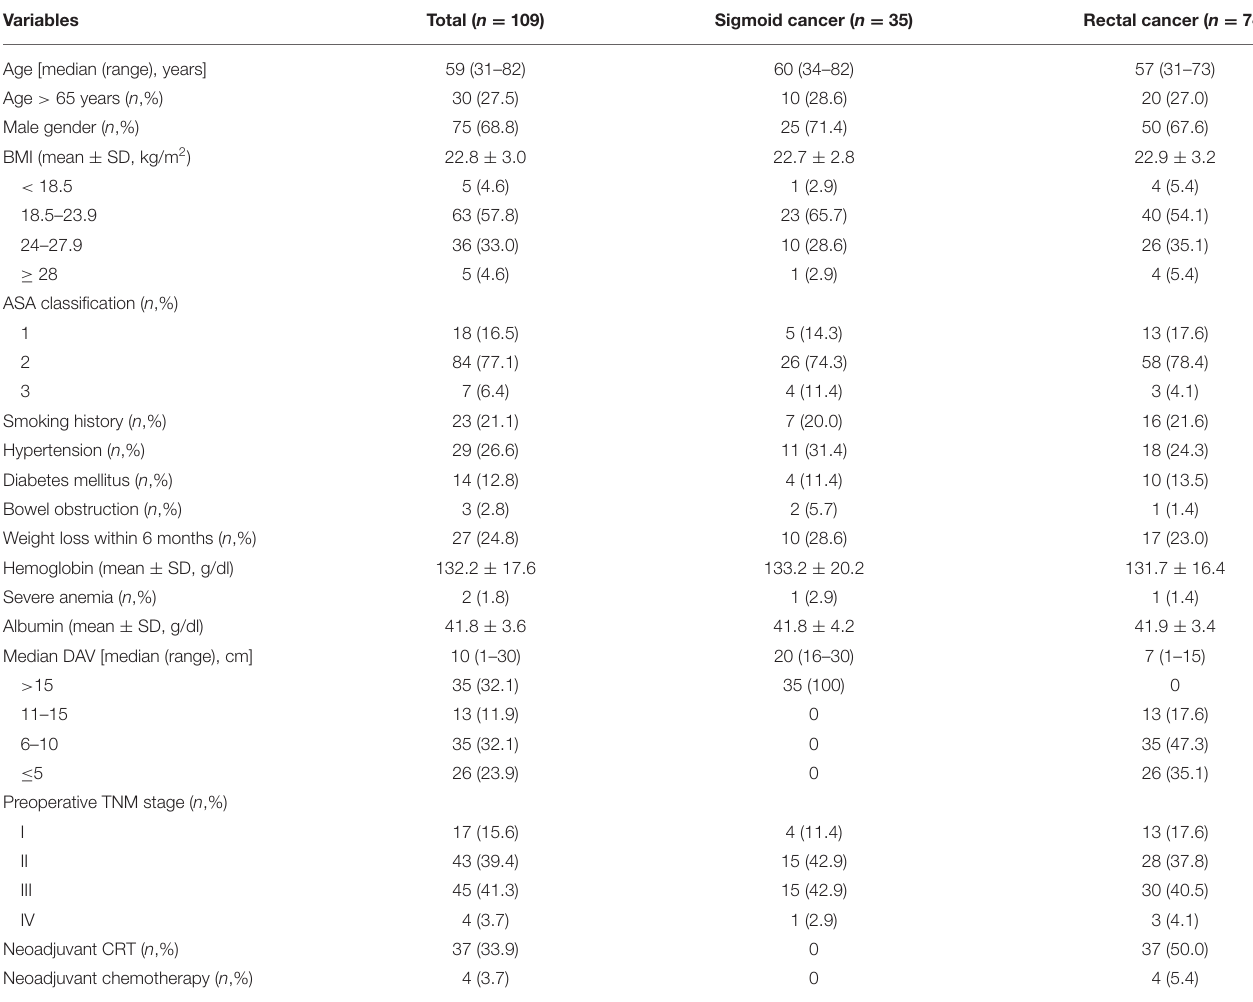
TABLE 1 | Clinical characteristics of study population.